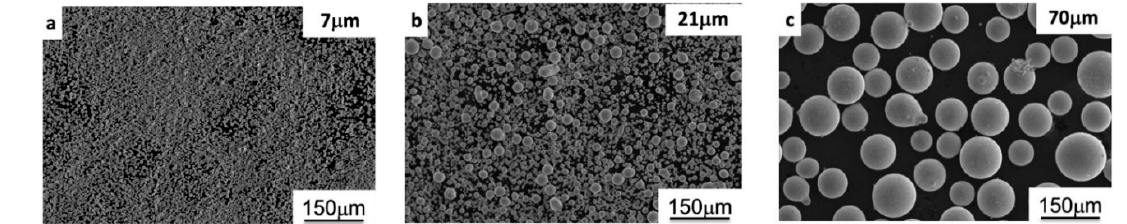
Figure 6. Micrographs of gas-atomized Inconel 718; ( a ) 7 µm powders, ( b ) 21 µm powders, and ( c ) 70 µm powders [31] .